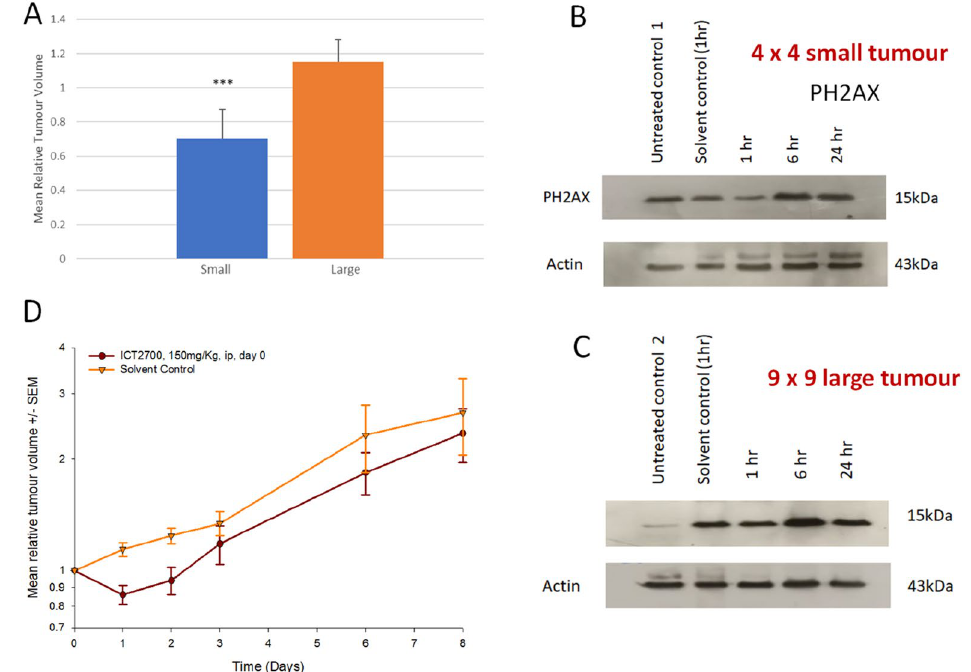
Figure 5. Administration of ICT2700 to FaDu tumours. Mice were treated with a single 150 mg/kg dose of ICT2700, i.p. either when tumours where a mean size of 60 mm 3 , or a mean size of 240 mm 3 ( A ). γH2AX was used as a marker of DNA double strand damage after 1, 6 and 24 h time points in small ( B ) and large ( C ) tumours (full blots provided in Fig. S6). ICT2700 impact on tumour growth delay ( D ).